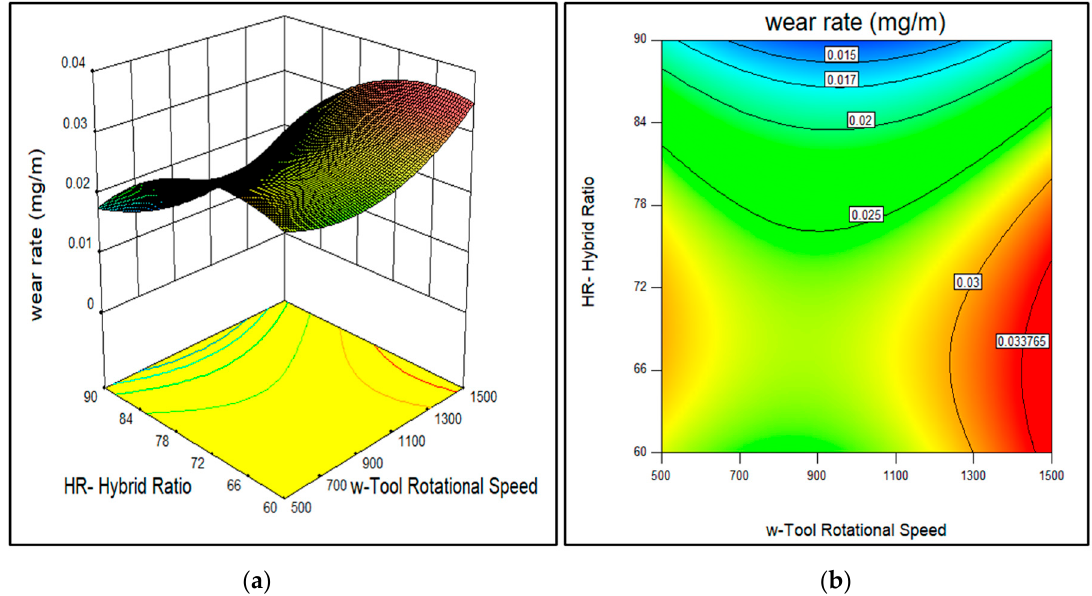
Figure 8. Effect of tool rotational speed and reinforcement hybrid ratio on the wear rate of AA7075-SiC/fly ash composites ( a ) 3D surface and ( b ) contour plot.